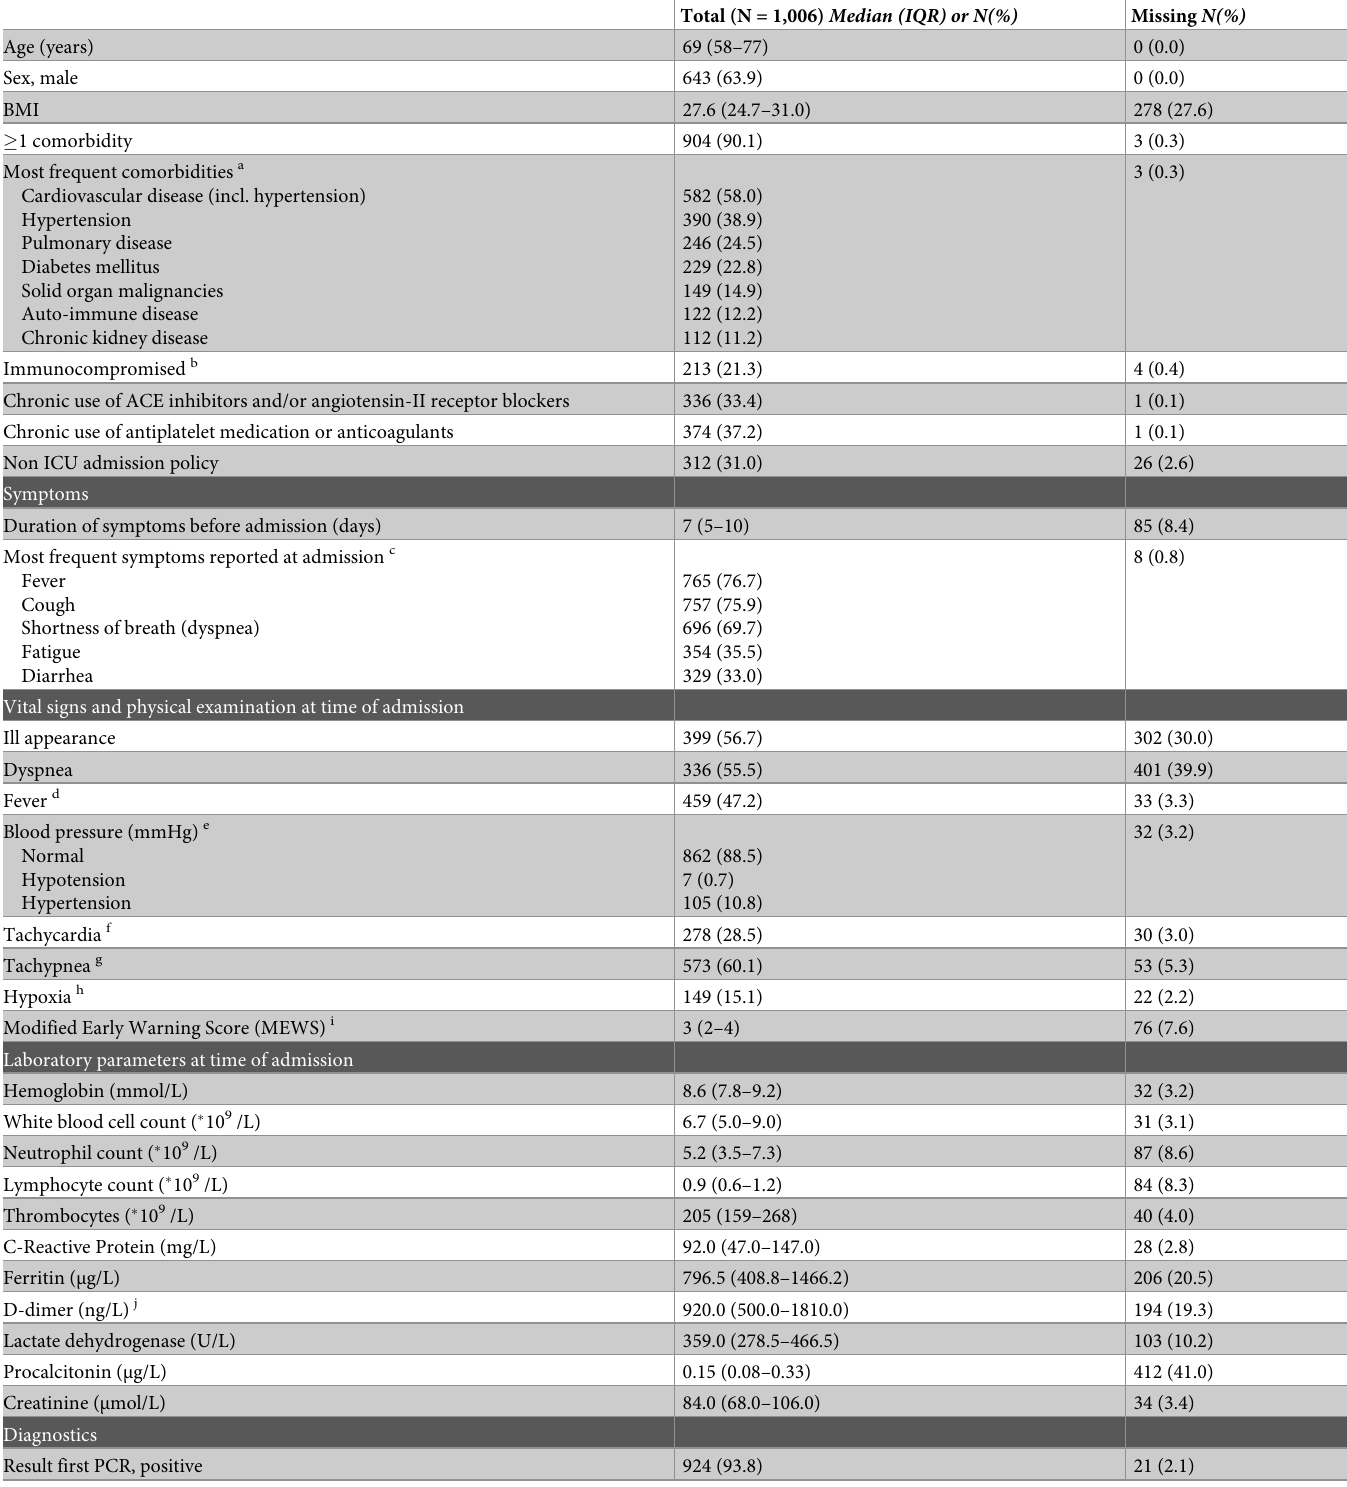
Table 1. Characteristics of the study